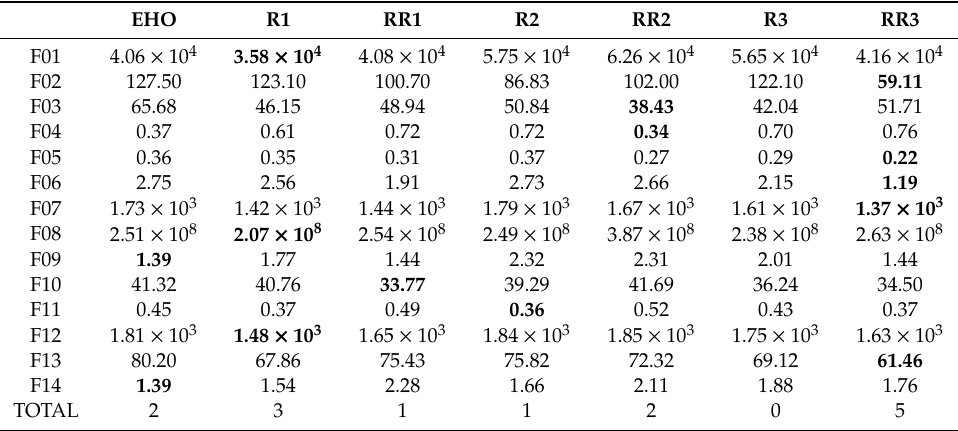
Table 15. Standard values obtained by EHO and six improved methods on fourteen CEC 2017 constrained optimization functions with D =